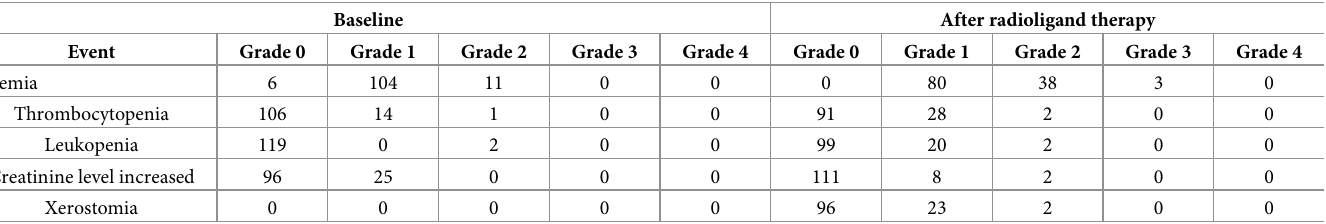
Table 6. Adverse events, according to CTCAE